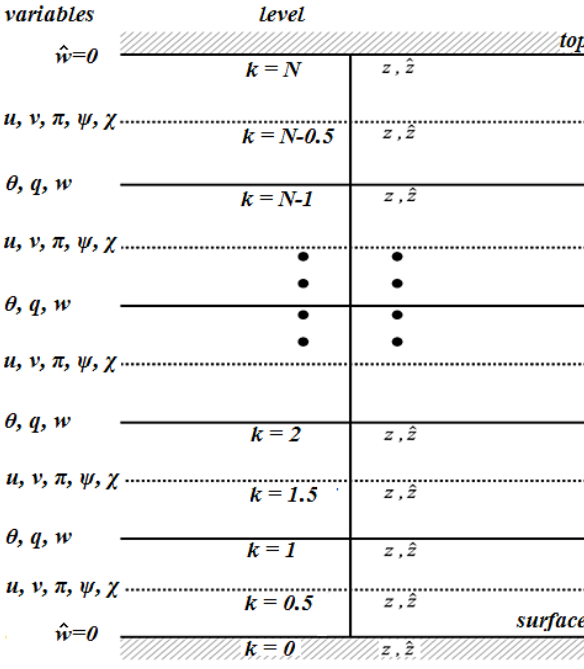
Figure 1. Schematic diagram of the atmospheric status and analy- sis variables of GRAPES-Var in the Charney–Phillips vertical grid (from Xue et al.,